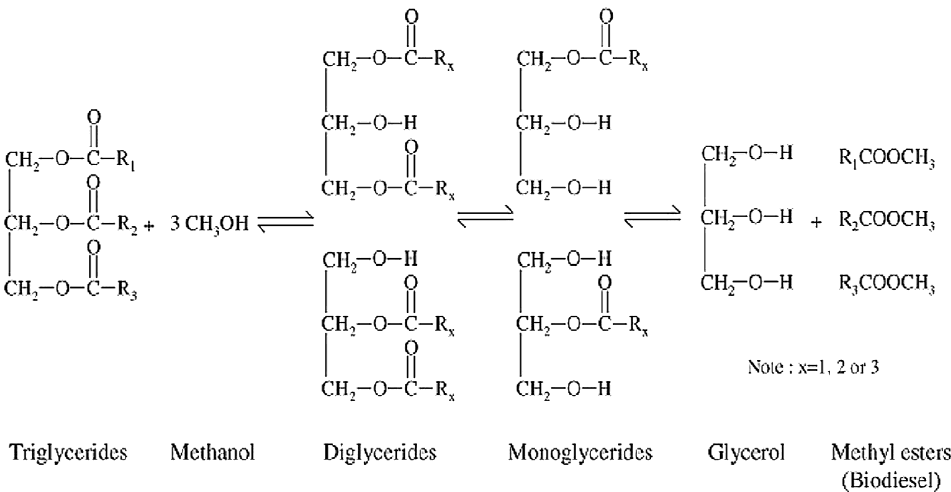
Figure 2. Formation of FAME from triglyceride